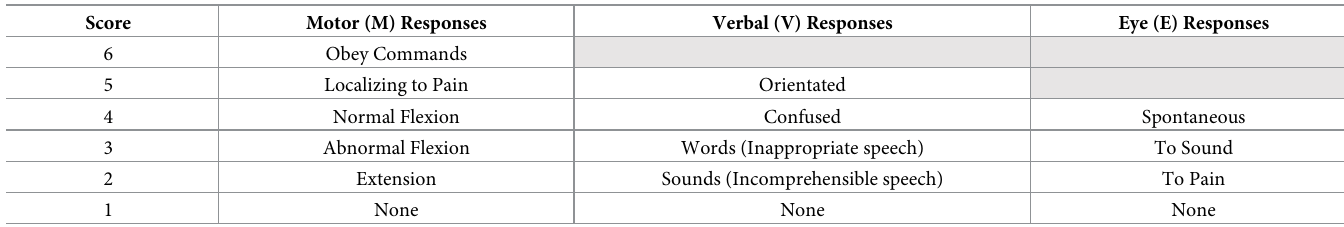
Table 1. The Glasgow Coma